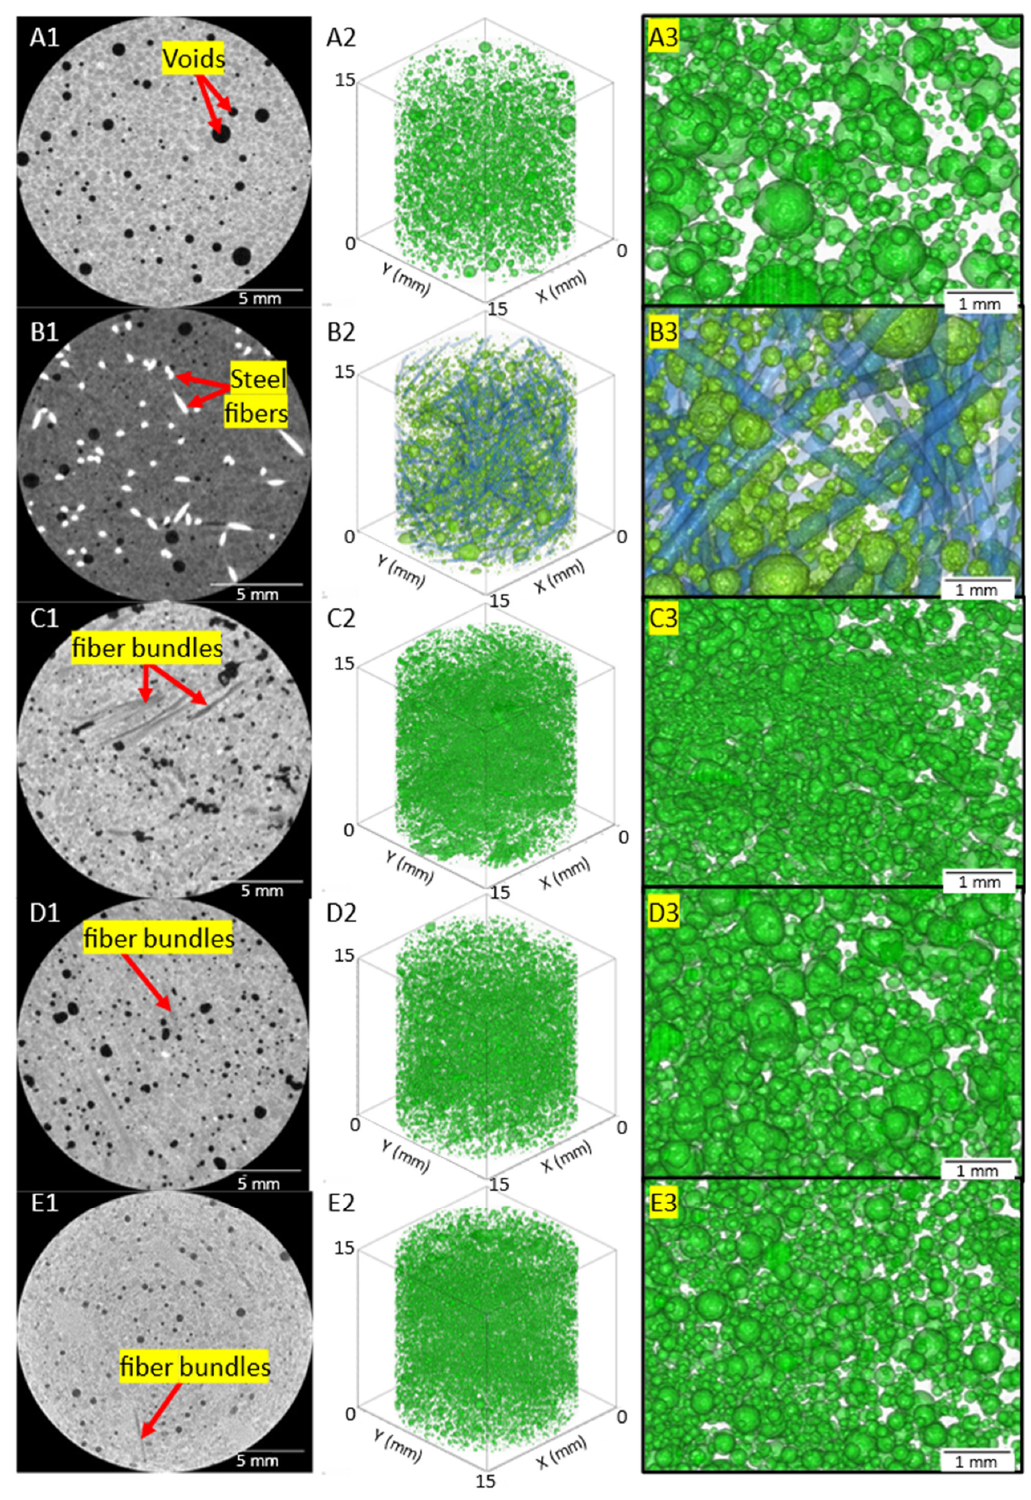
Figure 9. ( A1 – E1 ) 2D reconstructed cross-sections showing air voids, and fiber bundles phases within the host concrete. ( A2 – E2 , A3 – E3 ) 3D reconstructed volume showing voids spatially within the concrete volumes. ( A ) neat concrete; ( B ) steel fiber concrete; ( C ) Hexcel carbon fiber concrete; ( D ) Zoltek carbon fiber concrete; ( E ) recycled carbon fiber concrete. Note: For ( B2 ) and ( B3 ) steel fiber phase is shown.